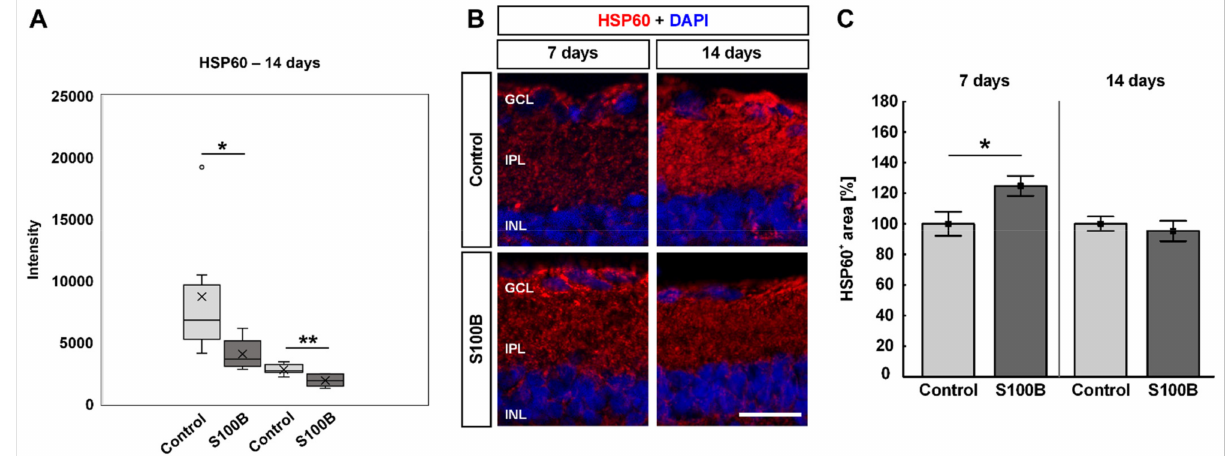
Figure 7. Altered HSP60 expression. ( A ) At 14 days after S100B immunization, the intensity of two peptide sequences of HSP60 was significantly down-regulated (peptide sequences: KPLVIIAED- VDGEALSTLVLNR: p = 0.033; DMAIATGGAVFGEEGLNLNLEDVQAHDLGK: p = 0.004). ( B ) An anti-HSP60 antibody (red) was applied on retinal cross-sections 7 and 14 days after immunization. DAPI was used to stain cell nuclei (blue). ( C ) At 7 days, the HSP60 + staining area was significantly increased in S100B animals ( p = 0.042). No alterations were revealed between S100B and control retinae after 14 days. Values for immunohistology are mean ± SEM and control values were set to 100%. GCL = ganglion cell layer; IPL = inner plexiform layer; INL = inner nuclear layer. Scale bar: 20 µ m. * p < 0.05; ** p < 0.01.